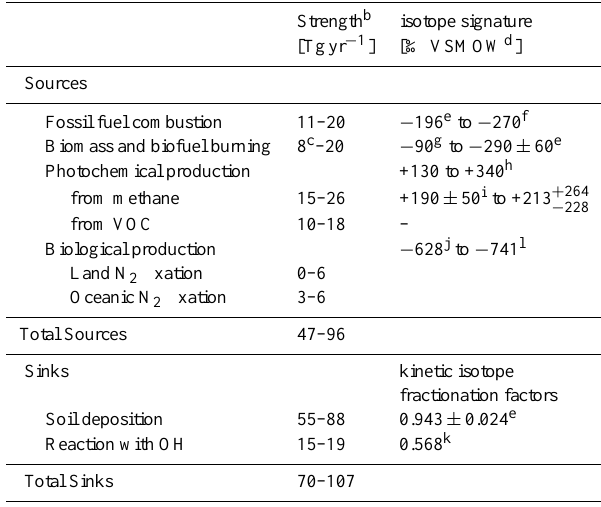
Table 1. Global sinks and sources of tropospheric molecular hydro- gen (H 2 ) and their isotope signatures a